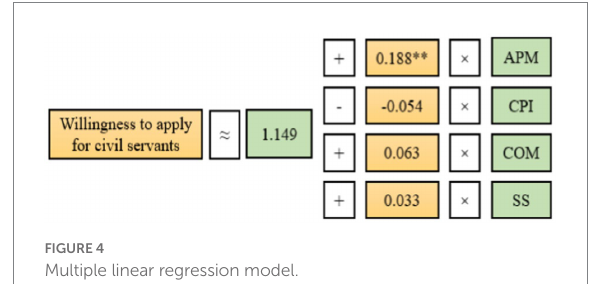
FIGURE 4 Multiple linear regression